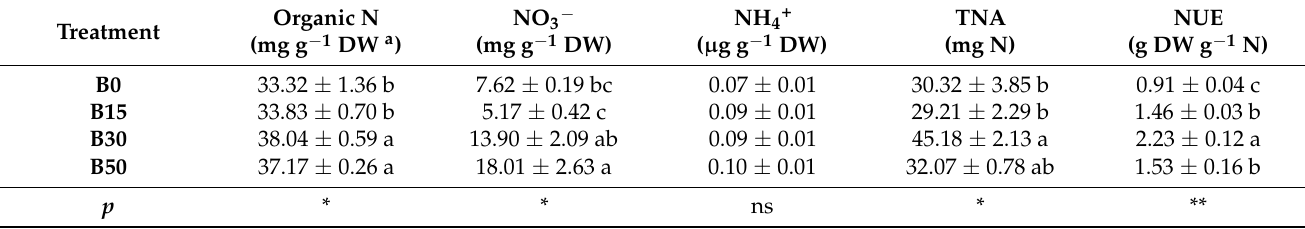
Table 9. Contents of N forms (NH 4+ , NO 3 − , Organic N), total N accumulation (TNA) and nitrogen use efficiency (NUE); defined as dry weight (DW) per unit of available N in the substrate, in shoots of lettuce plants grown on biochar:peat substrates.